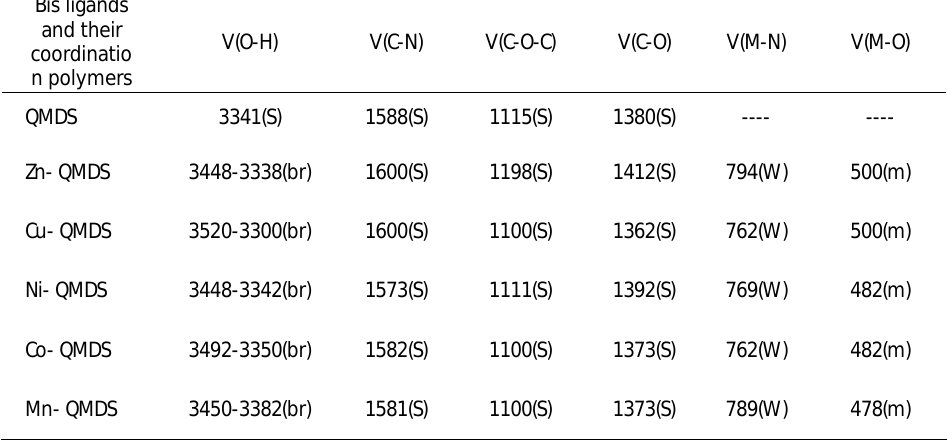
Table IITable II Infrared Frequencies (cm-1) of QMDS ligand and it’s coordination polymers. Bis ligands and their